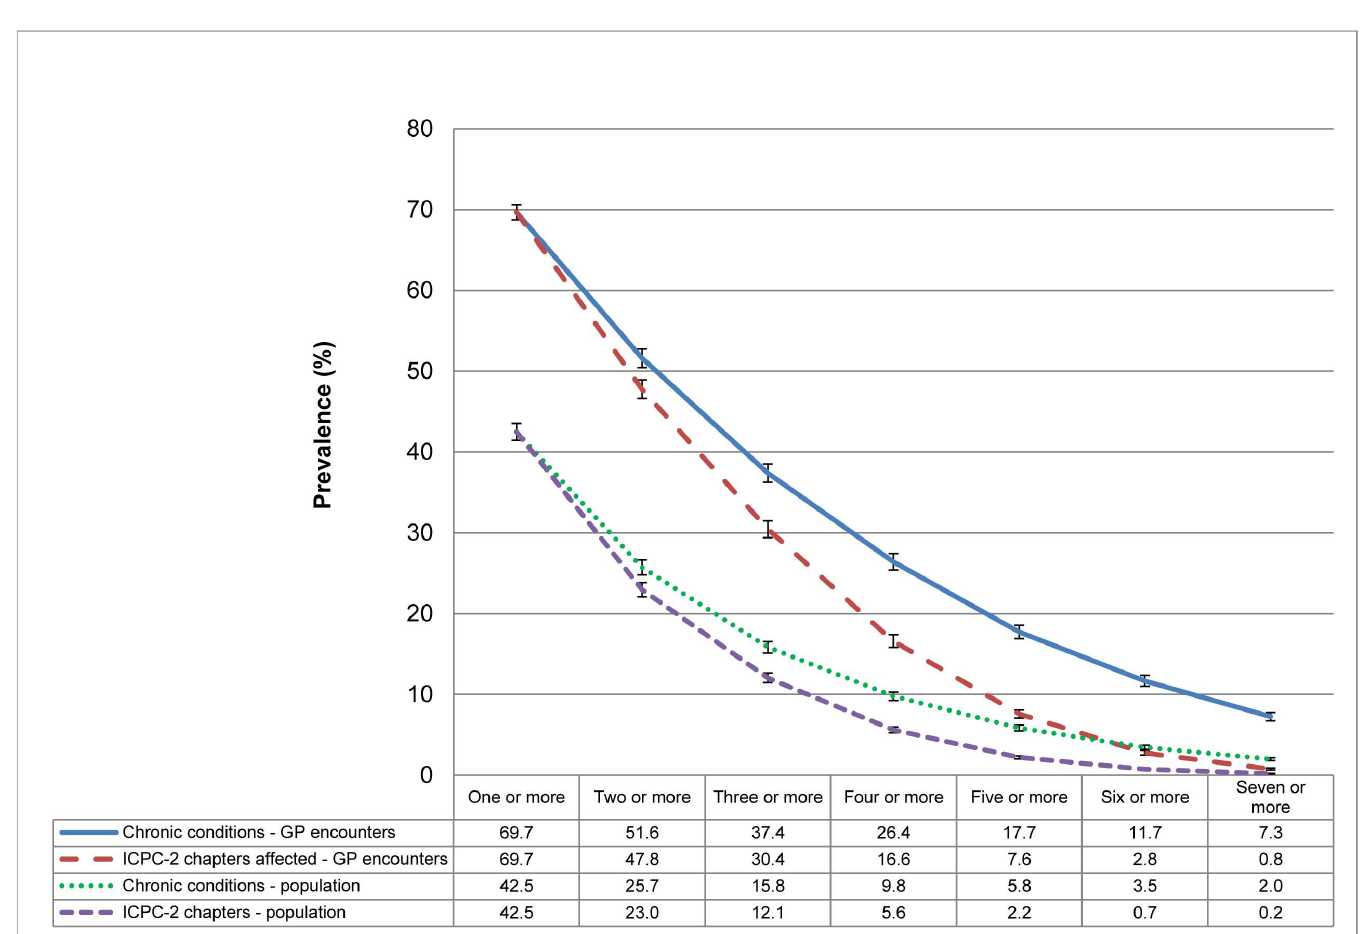
Fig 1. Prevalence of the number of chronic conditions among patients at encounters and people in the Australian population. (Note to go below Fig 1). Note: ICPC-2 chapters used as a proxy for body system.